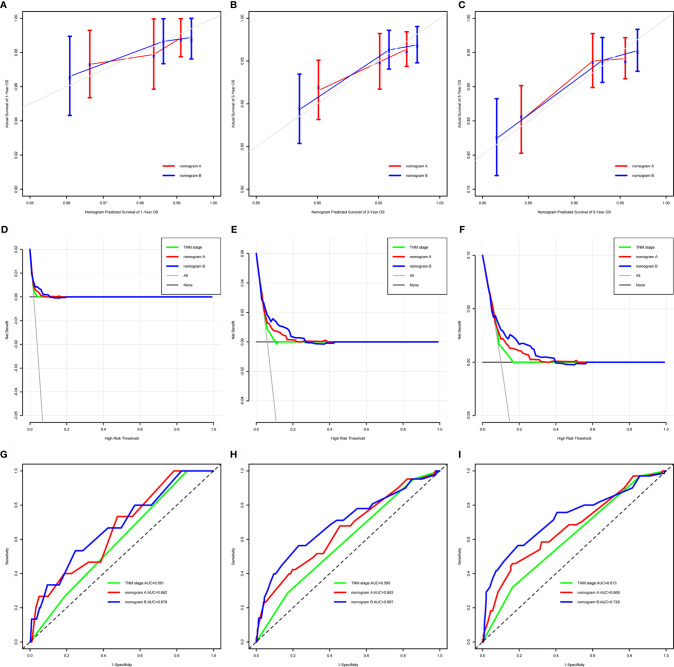
Calibration curves, decision curves, and time-dependent receiver-operating characteristic curves (tROC) to predict 1-, 3- and 5-year overall survival (OS). OS = overall survival; AUC = area under the receiver-operating characteristic curve. (A–C) Calibration curves for 1-, 3- and 5-year OS. Actual OS is plotted on the y-axis; nomogram-predicted probability of OS is plotted on the x-axis. The diagonal dotted line represents a perfect prediction by an ideal model. The colored solid line represents the performance of the nomogram, of which a closer fit to the diagonal dotted line represents a better prediction. (D–F) Decision curves for 1-, 3- and 5-year OS, the x-axis represents the threshold value, and the y-axis represents the net benefit rate after the advantages minus the disadvantages. Under the same threshold probability, a larger net benefit implies that patients can obtain the maximum benefit using the diagnosis of this model. (G–I) Time-dependent receiver-operating characteristic curves for 1-, 3- and 5-year OS, the x-axis represents the sensitivity value (true positive rate), and the y-axis represents the 1-specificity (false positive rate). A larger AUC implies that patients can obtain the maximum prediction using this model.